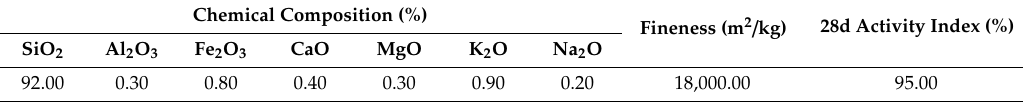
Table 3. Chemical composition and physical indexes of silica fume.